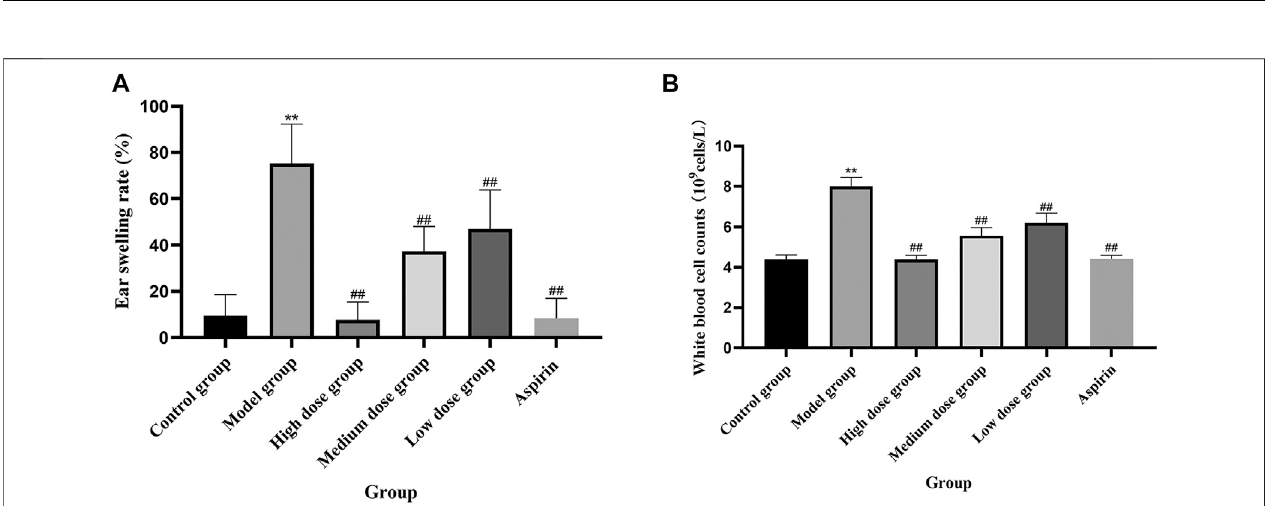
FIGURE 9 | Xylene-induced ear swelling in mice. (A) Ear swelling rate, (B) White blood cell counts.